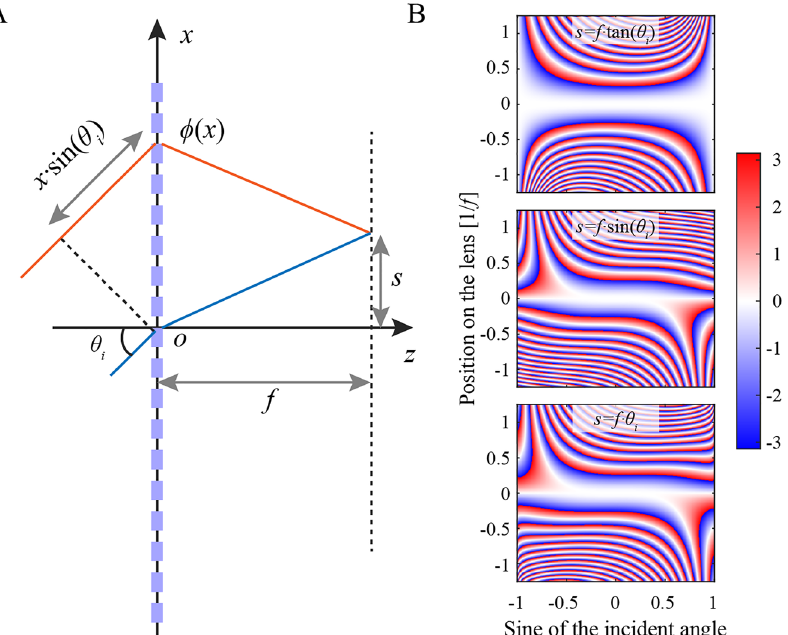
Figure 1: Schematic illustration of perfect wide-angle metalenses and corresponding ideal phase profiles. (A) A flat lens is illuminated with the parallel light incident at angle θ i with the optical axis. (B) Ideal phase pro fi les of perfect wide-angle metalenses. Their corresponding focus offset functions from top to bottom are s ( θ i ) = f ·tan θ i , s ( θ i ) = f ·sin θ i , and s ( θ i ) = f · θ i ,